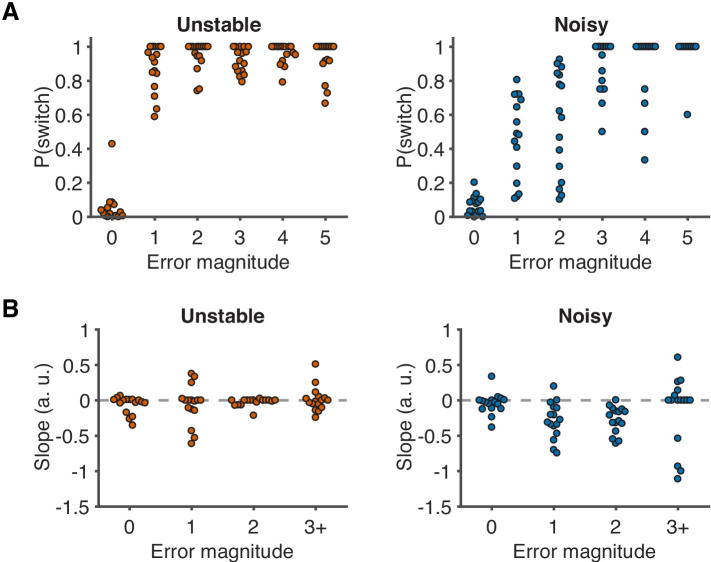
Distributions of behavior as a function of error magnitude.(A) Distributions of switch probability as a function of error magnitude. Each data point represents one participant. (B) Distributions of slopes of switch probability against error history as a function of error magnitude. Each data point represents one participant.